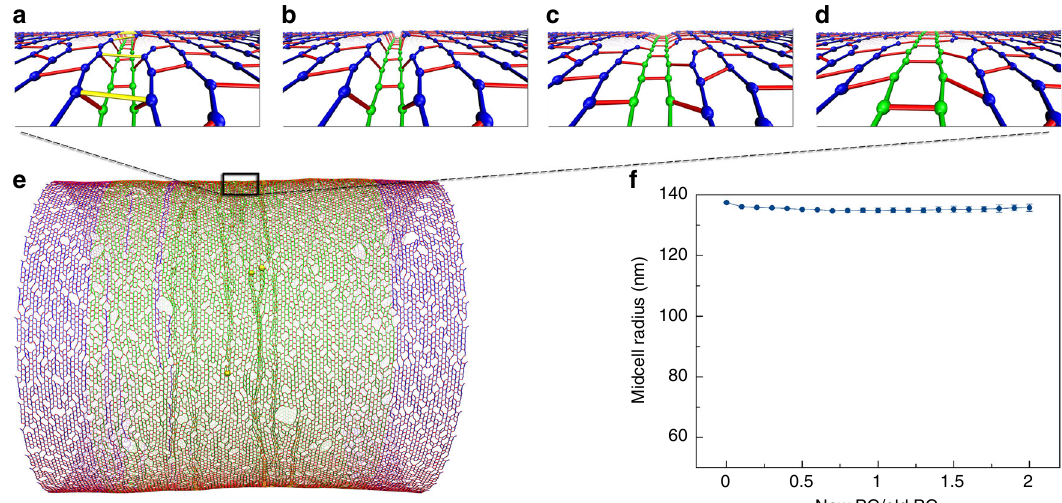
Fig. 4 Cell wall synthesis with a make-before-break mechanism. a – d show the make-before-break mechanism occurring in sequence: a new cell wall was made underneath the existing network. The peptide crosslinks above the new peptidoglycan (PG) are highlighted in yellow. b The highlighted crosslinks were cleaved after complete hoops of new PG were made. c , d show the relaxation of the network after the cleavage event. e A snapshot of the PG cylinder shows that constriction did not occur with insertion of new PG. f The pro fi le of the midcell radius with respect to the amount of new PG inserted. The averages of four simulations are shown. Error bars indicate standard